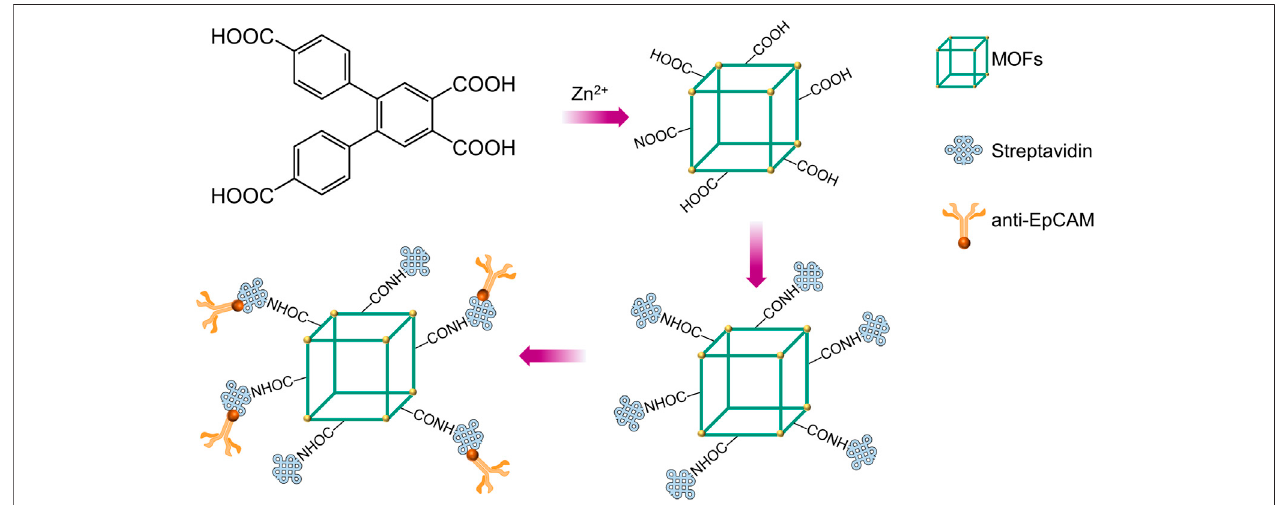
FIGURE 7 | Schematic Illustrating the Synthetic Strategy for fabricating a MOF-Based Immunotrapper (Qi et al., 2017).